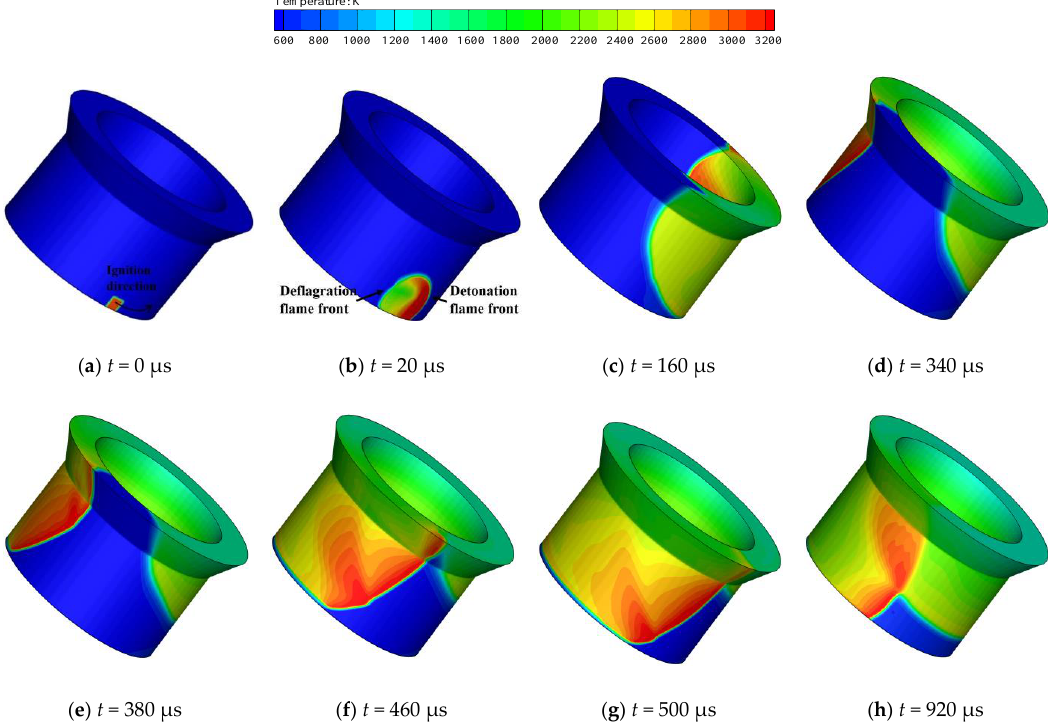
Figure 8. Temperature contour in the RDC with θ = 30°.